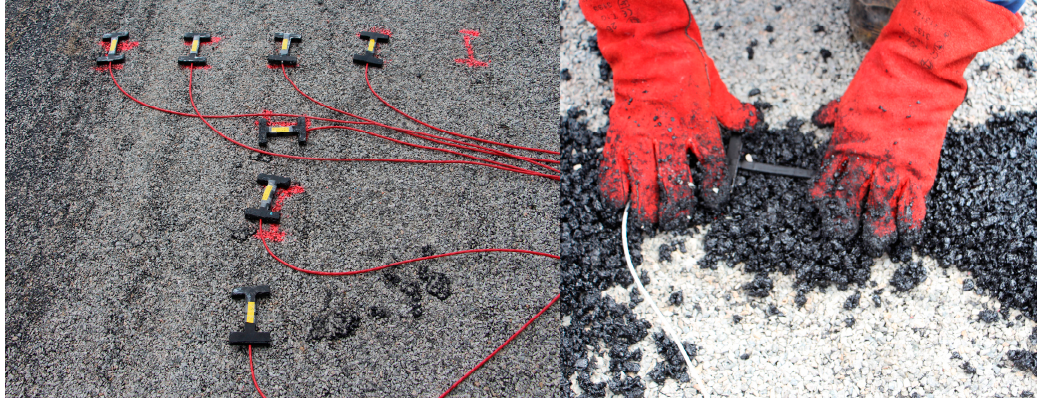
Figure 3. Schematic representation of the pavement structure with embedded sensors.